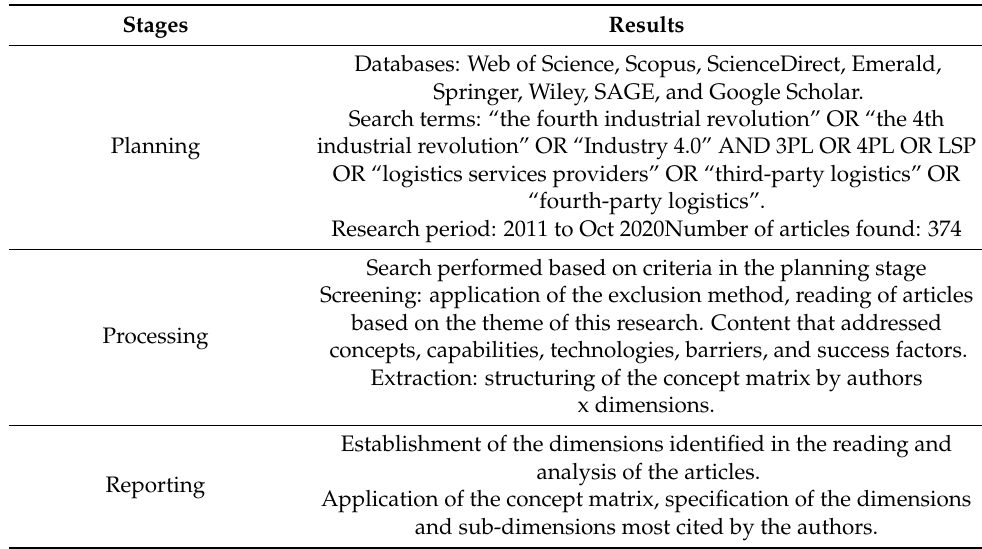
Table 1. Systematic Literature Review